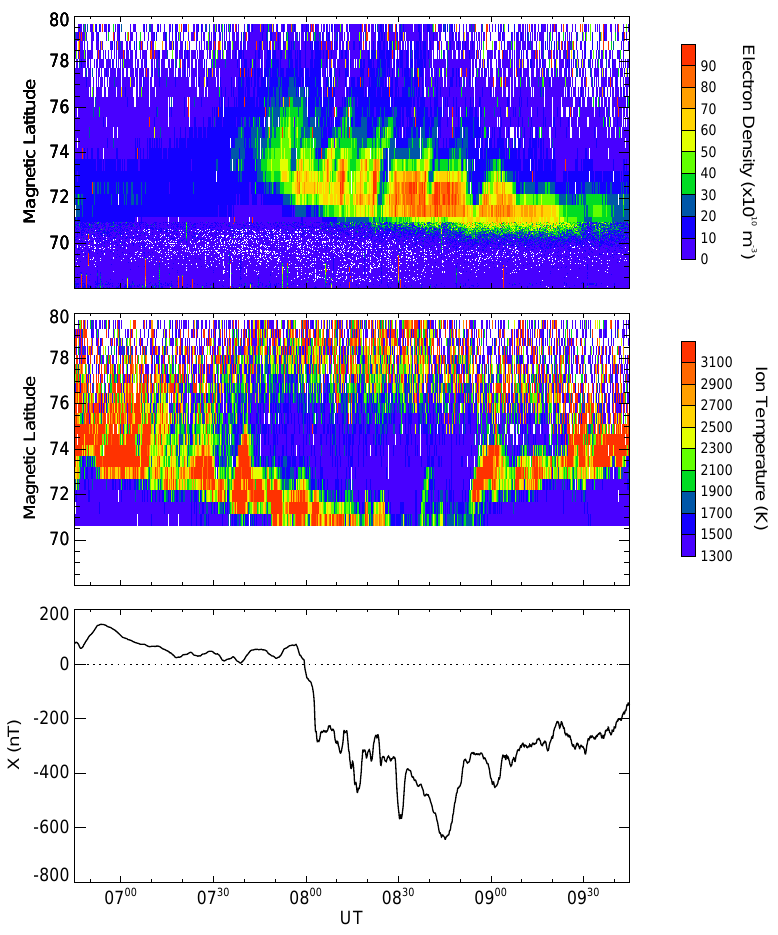
Fig. 4. The top two panels of this figure present electron density (upper panel) and ion temperature measurements (central panel) from beam 1 of the EISCAT VHF radar between 06:45 and 09:45UT on 23 November 1999 as a function of geomagnetic latitude. The lower panel illustrates the X component in nanoTeslas of the ground magnetic signature from the Fort Smith magnetometer of the CANOPUS